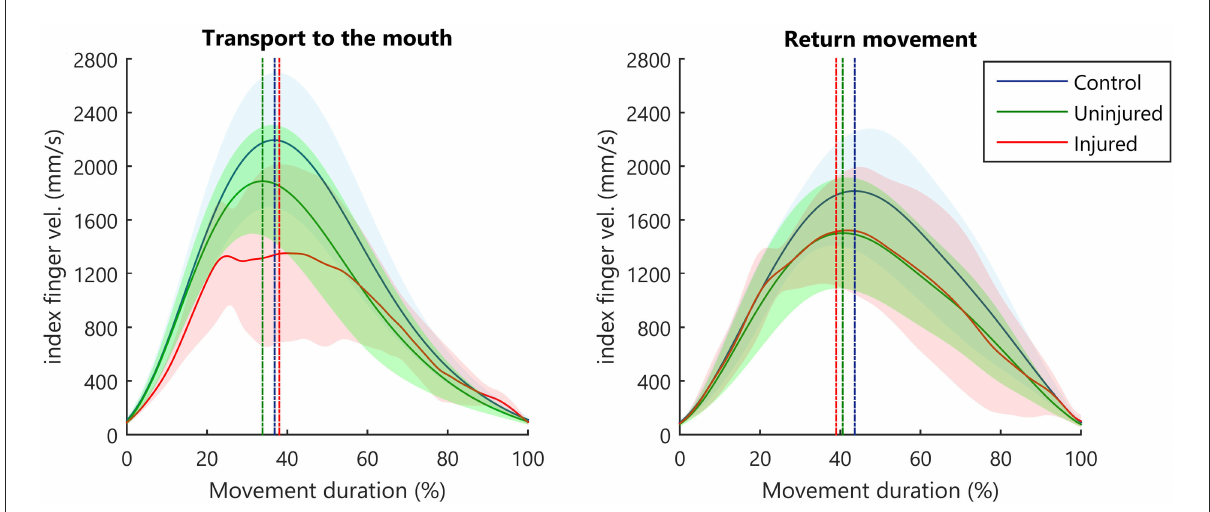
FIGURE2 Kinematic profile of hand movement. Average index finger velocity (solid line), and SD (shaded area). The straight vertical dashed line indicates the mean instant for hand PV.